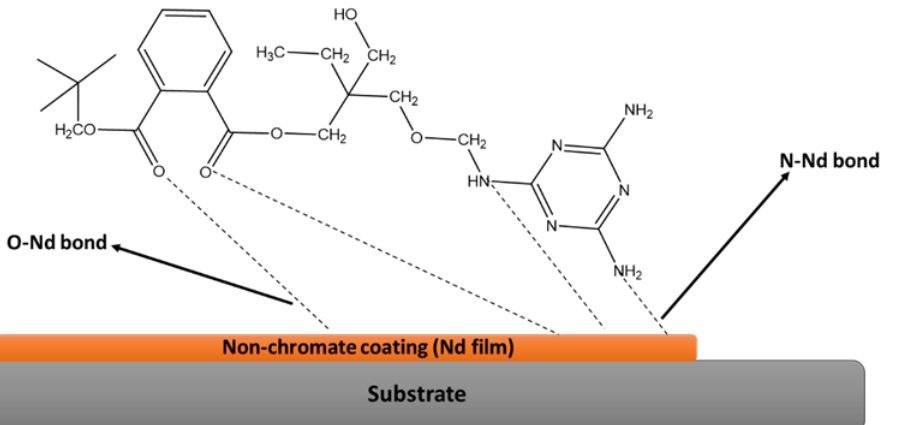
Figure 3. The significance of neodymium oxide film on the morphology, surface free energy calculations, and adhesion properties of a polyester/melamine coating [21].